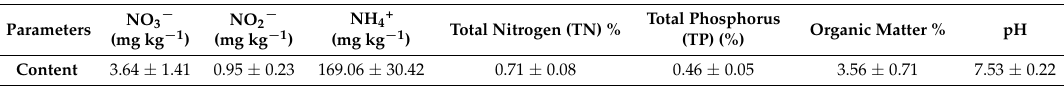
Table 1. Main parameter characteristics of the sediment samples collected from the eutrophic